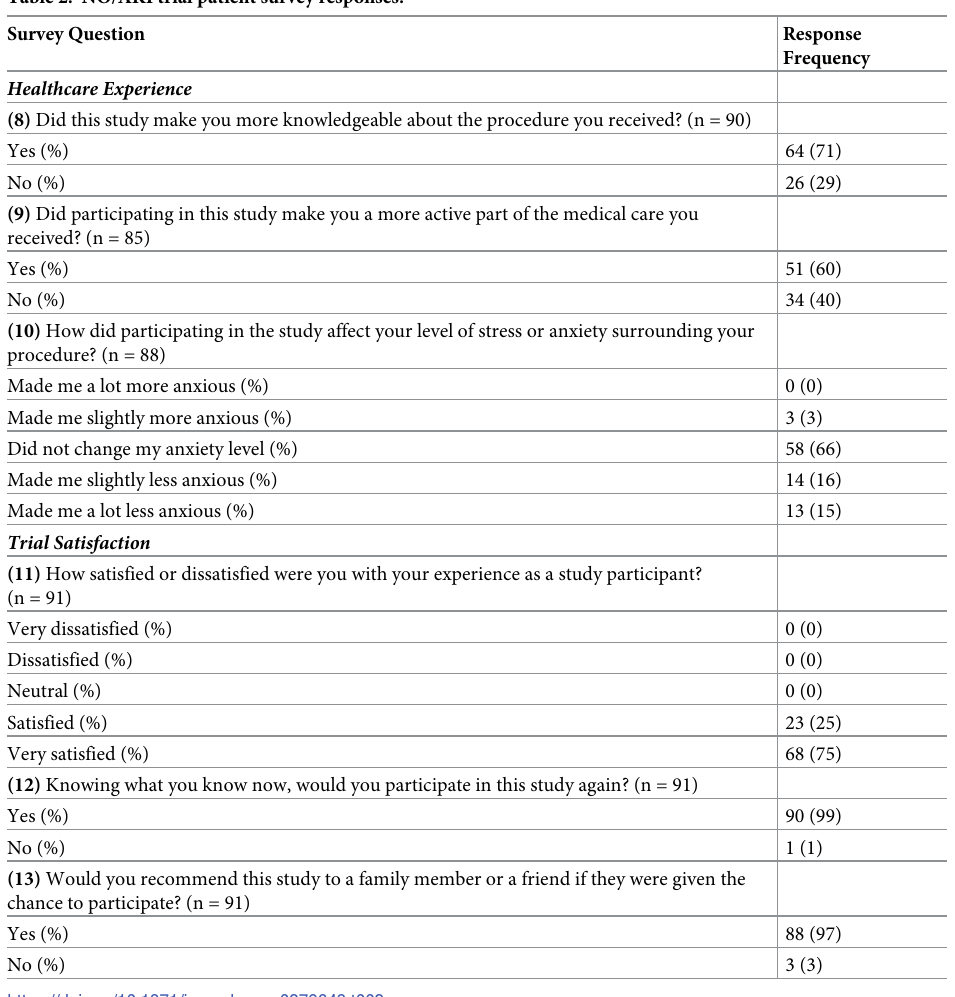
Table 2. NO/AKI trial patient survey